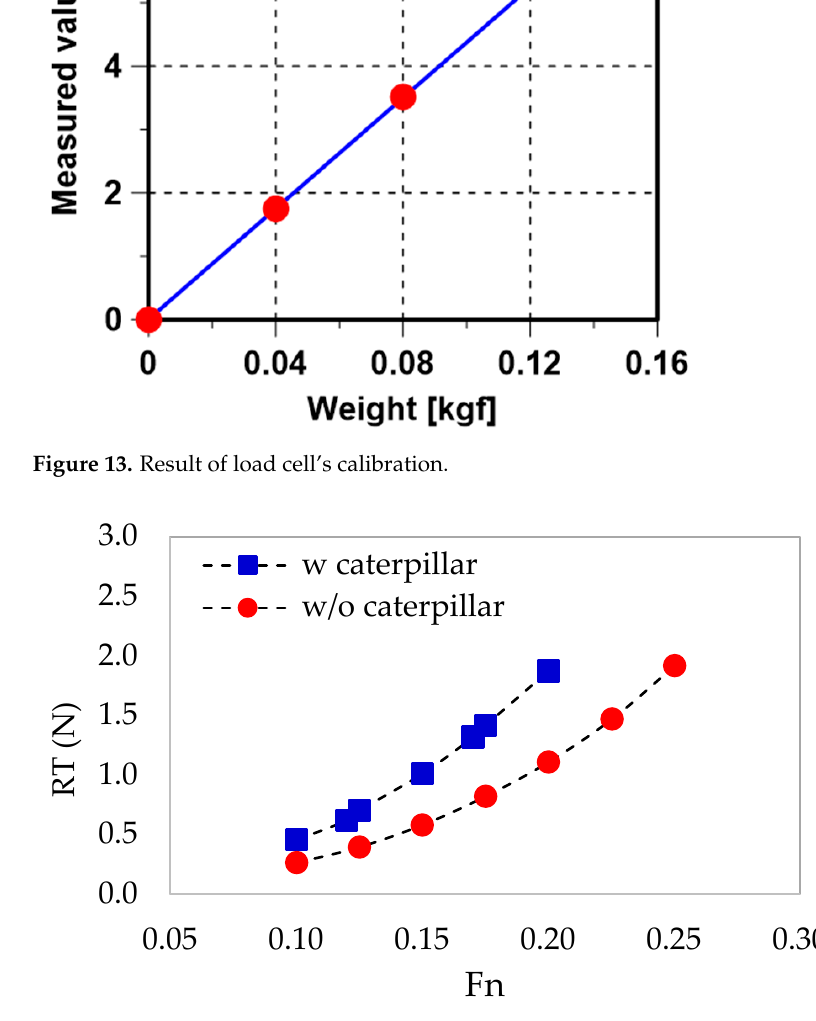
Figure 14. Model test results of an amphibious vehicle w/and w/o caterpillars.